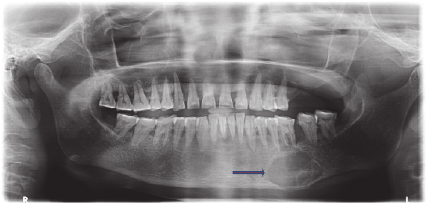
Figure 3: Radiolucent lesion extending from 34 to 37.